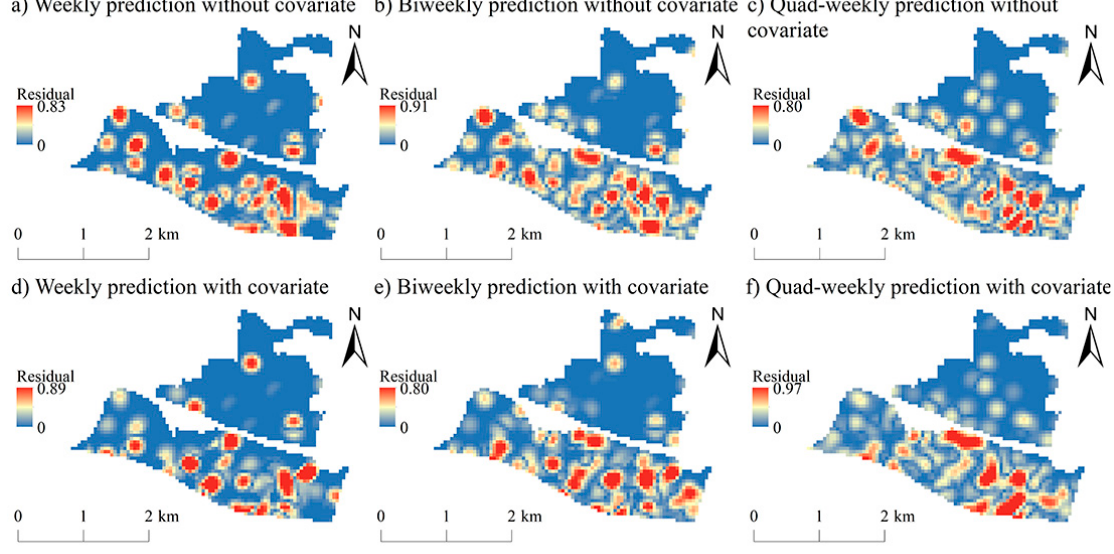
Figure 7. The absolute differences between the predictions and the reality (( a – c ), prediction without the covariate; ( d – f ), prediction with the covariate).